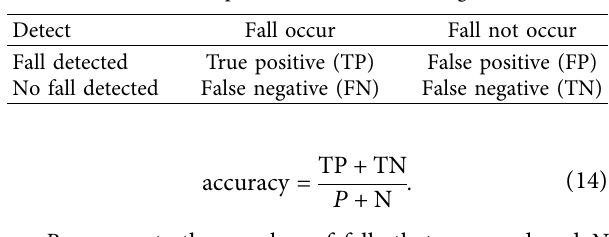
Table 3: Four possible cases of fall recognition.